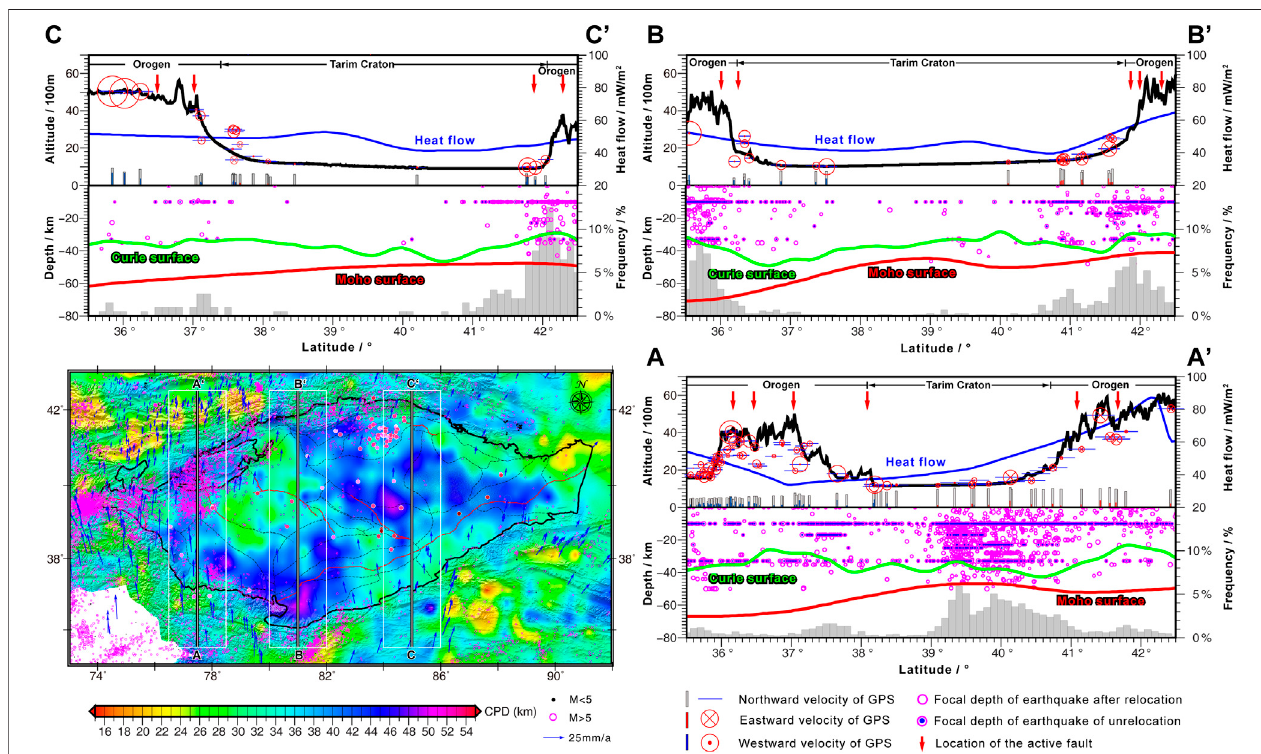
FIGURE 8 | Interpreted transects AA ’ , BB ’ , and CC ’ crossing the Tarim Basin and active orogenic belts. In the inset, the black and purple circles are earthquakes originated from ISC (http://www.isc.ac.uk/). The blue arrows represent GPS velocities relative to Siberia (Zheng et al., 2017). In the sections, the thick solid blue and green curves show the Curie surface and Moho surface ( Figure 9B ; Teng et al., 2014), respectively, and black curves are the topographic relief. The purple circles are earthquakeswithfocaldepthsafterrelocation.Incontrast,thebluecirclesareearthquakeswithfocaldepthsofnon-relocation.Theprobabilityplotsofearthquakes intheTarimBasinanditsenvironsareexhibitedinthesections. Theredarrowsrepresentthelocationsofactivefaultsintheorogenicbelts.Thenorthwardandeastward or westward velocities of GPS are marked by horizontal bars and circles with a fork or point in the center, respectively. The velocities of GPS in the sections are proportional to the size of